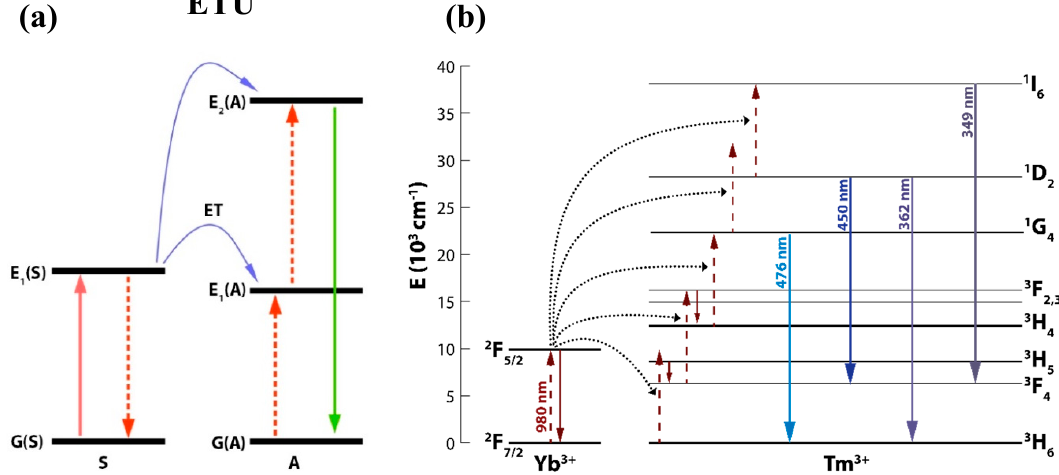
Figure 1. ( a ) The energy transfer upconversion (ETU) mechanism. ET – energy transfer, S – sensitizer, A – activator. ( b ) Schematic energy level diagram for the Yb 3 + –Tm 3 + pair with transitions responsible for the UV and visible light emissions upon 980 nm excitation.